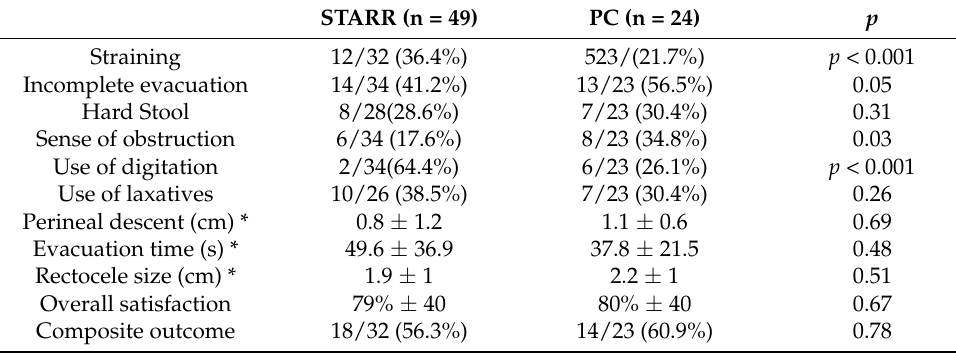
Table 3. Postoperative evaluation of the study groups.